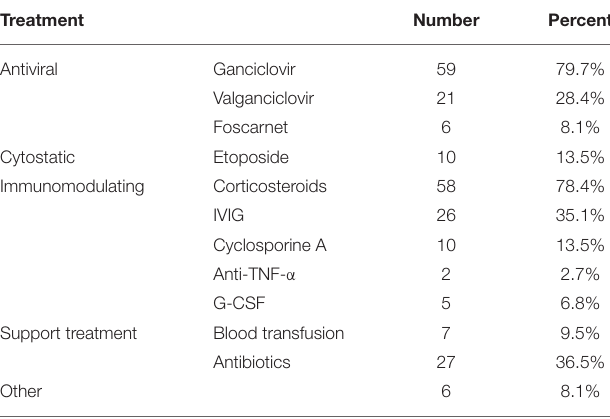
TABLE 6 | The distribution of use of each treatment option in the patient group.